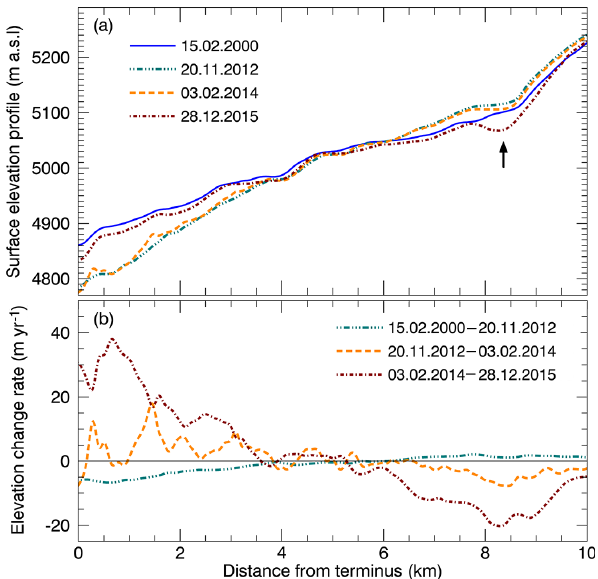
Figure 11. (a) Elevation profiles from 2000, 2012, 2014, and 2015, and (b) the rate of elevation change between the periods 2000–2012, 2012–2014, and 2014–2015. Profiles are taken along the transect in- dicated in Figs. 9 and 10, and the black arrow indicates the location of the surface hollow remaining after the